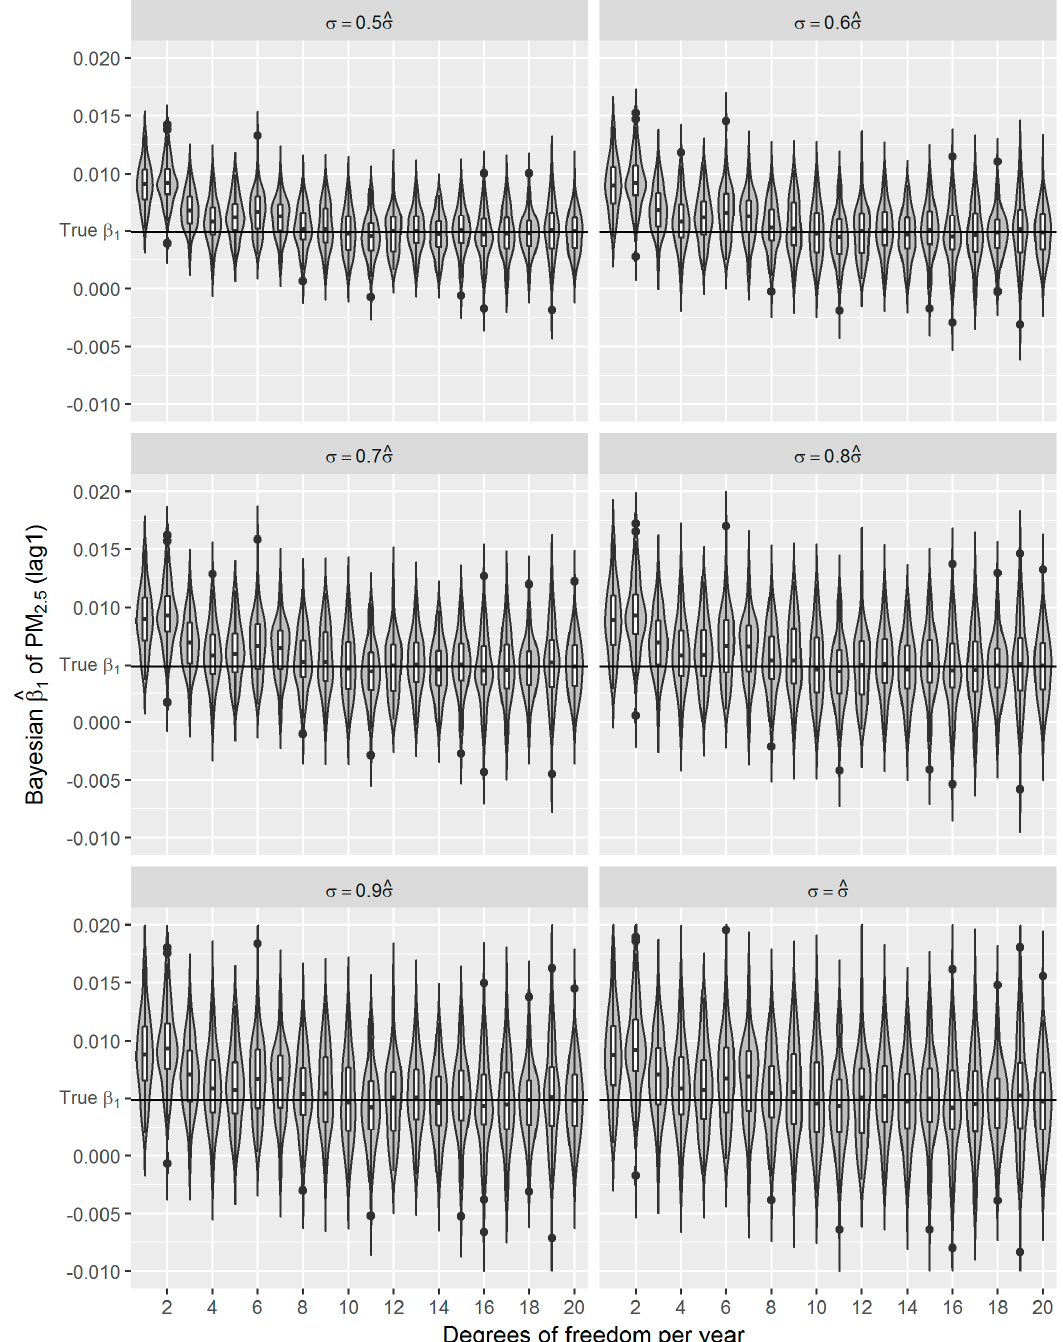
Figure 6. Distributions of Bayesian (cid:98) β 1 s for simulated data with different noises ( σ = 0.5 − 1.0 (cid:98) σ ) and degrees of freedom (1–20 per year) for S ( t ); the true β 1 = 0.0049. Table 4. Mean (SD) of estimated 𝛽(cid:4632) (cid:2869) s derived from Bayesian GAMs.